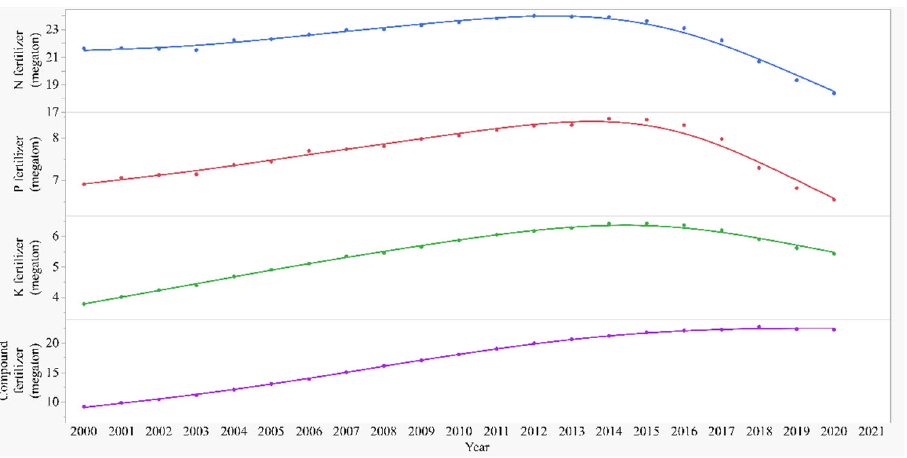
Figure 6. Different types of fertilizers (nitrogen, phosphate, potassium, and compound) used by the whole agricultural production in the country in the recent 20 years. Correlations of GPA, EGPA, MGPA, and LGPA with different kinds of fertilizer are shown in Figure 7. Nitrogen was not significantly correlated with GPA, EGPA, MGPA, or LGPA. Phosphate positively correlated with MGPA (R 2 = 0.396, p = 0.0068) and LGPA (R 2 = 0.571, p = 0.0004). Potassium positively correlated with GPA, EGPA, MGPA, and LGPA; the coefficient was largest in LGPA (R 2 = 0.87). Compound fertilizer positively corre- lated with GPA, EGPA, MGPA, and LGPA; the coefficient was largest in GPA (R 2 = 0.952).